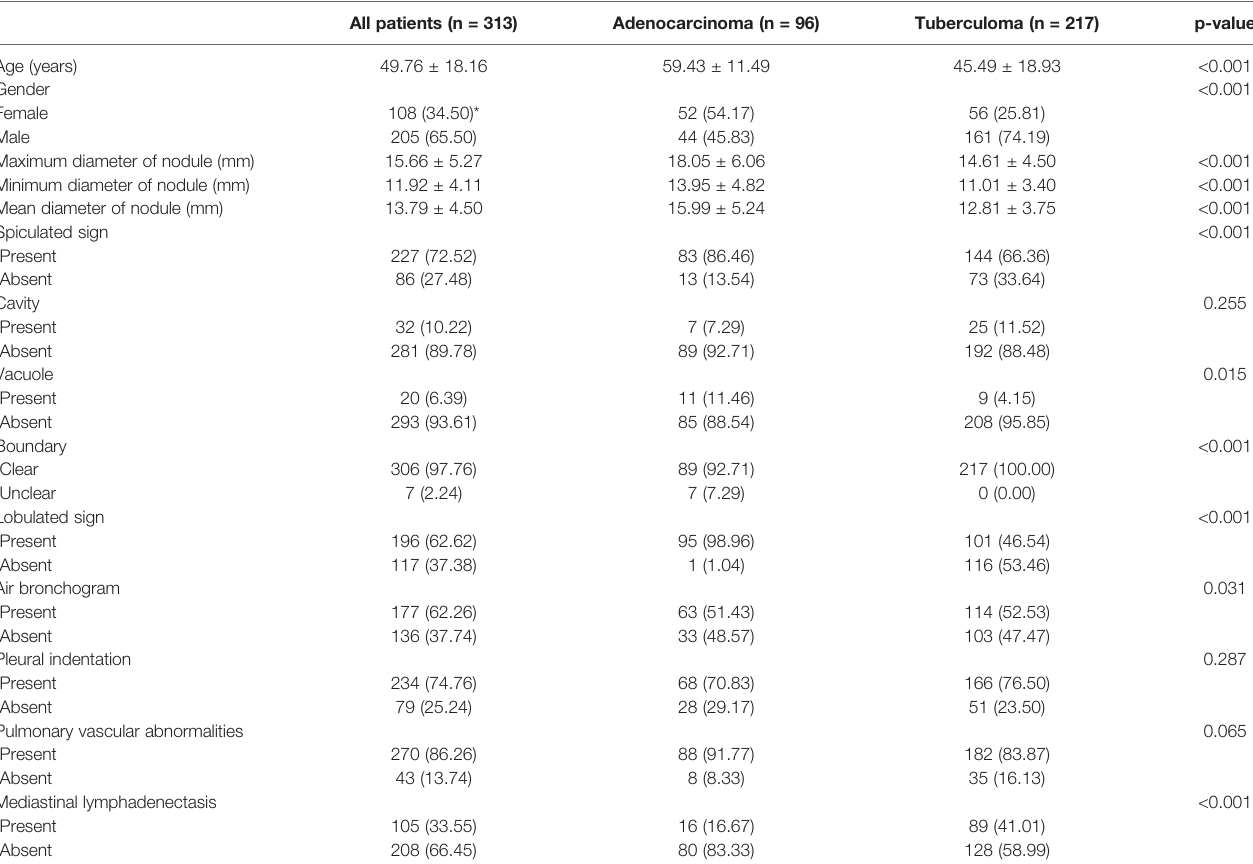
TABLE 1 | The clinical and CT image characteristics of